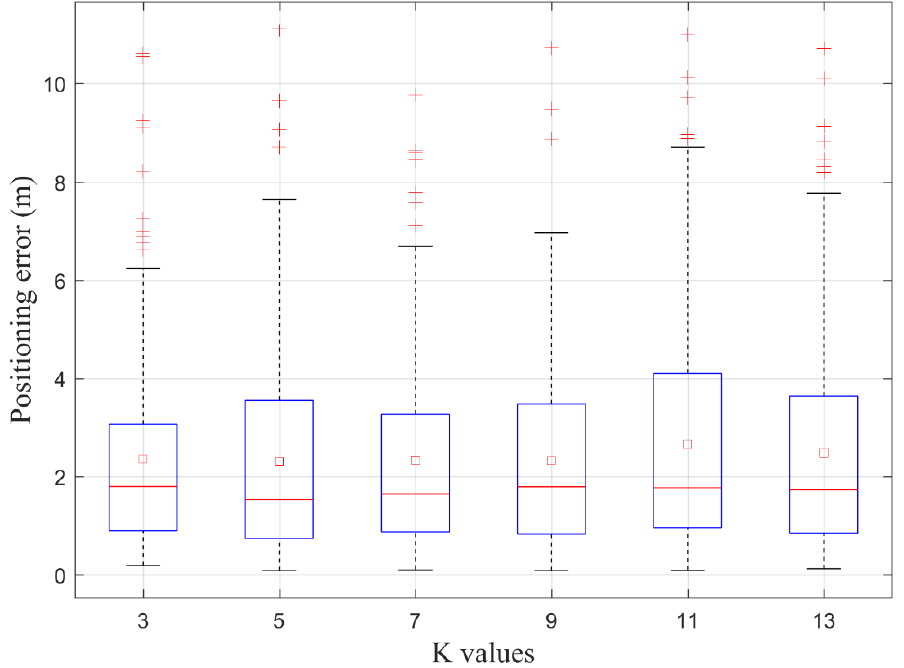
Figure 9. Positioning errors of the proposed method with different K values, where red line in the blue box denotes median error, the red square in the blue box represents ME, and the red plus outside of the blue box represents outliers with large errors. Table 4. Statistics of positioning errors of the proposed method with different K values (m).